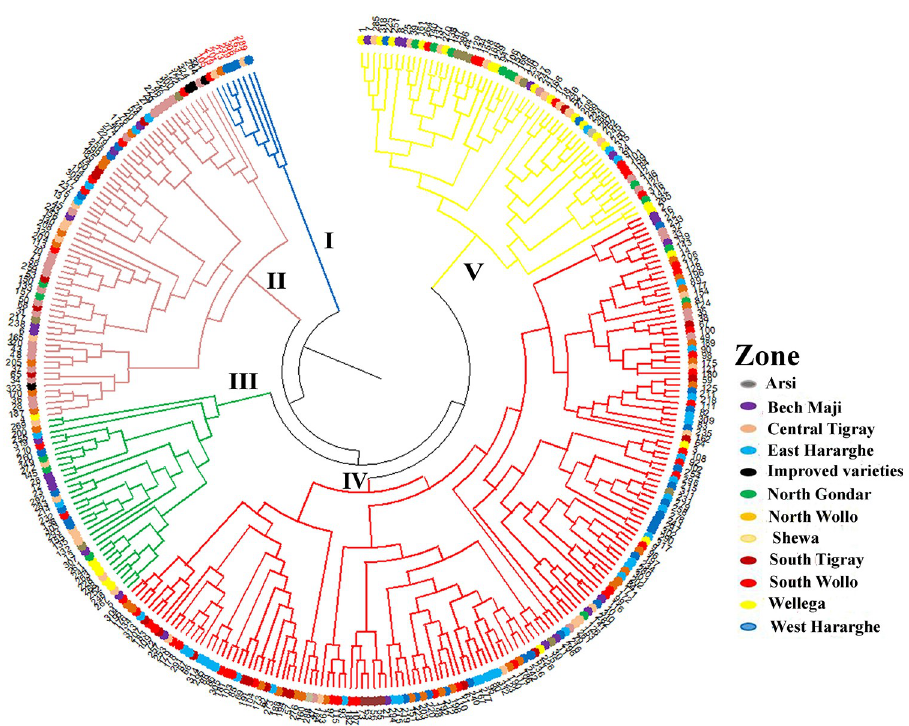
Fig 8. Cluster analysis of the 324 sorghum genotypes using phenotypic data of the six studied traits revealing five major clusters (I to V). Genotypes in cluster-I (red font) are high yielding.